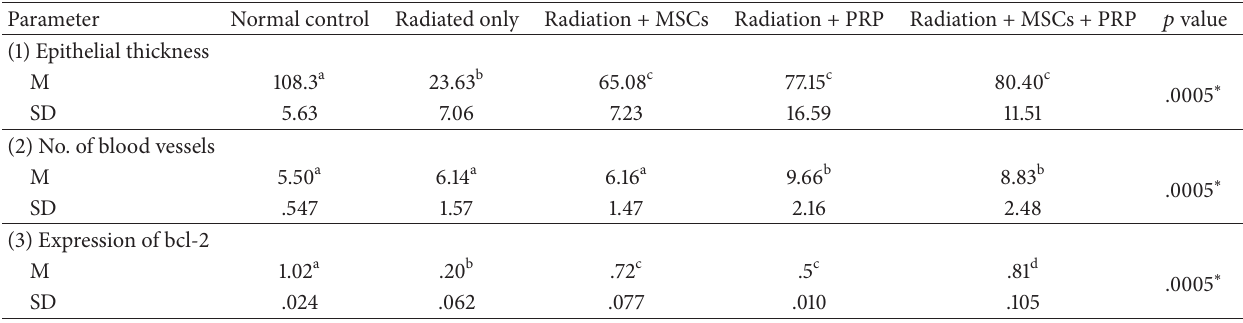
Table 1: Comparison of (epithelial thickness, number of blood vessels, and expression of bcl-2) between control group and different experimental groups after 3 days of irradiation.